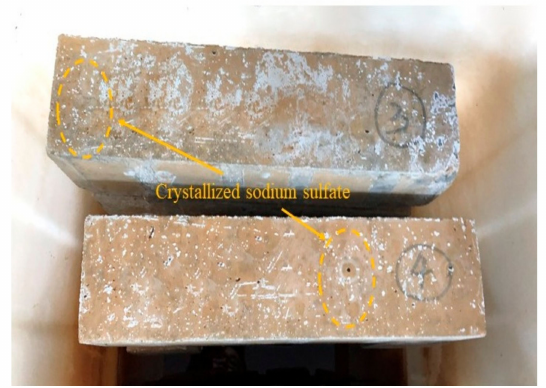
Figure 6. Crystallized sodium